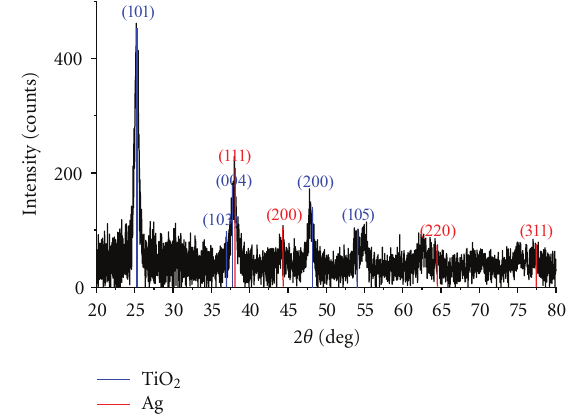
Figure 4: XRD peaks of the TiO 2 /Ag composite film with UV exposure for 120 minutes on an FTO glass substrate. (Note: graph plotted by OriginLab software